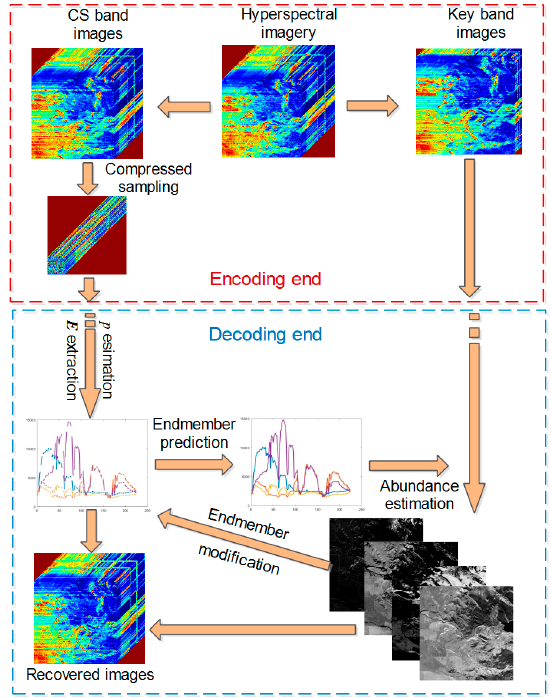
Figure 1. Framework of distributed compressed hyperspectral sensing (DCHS).